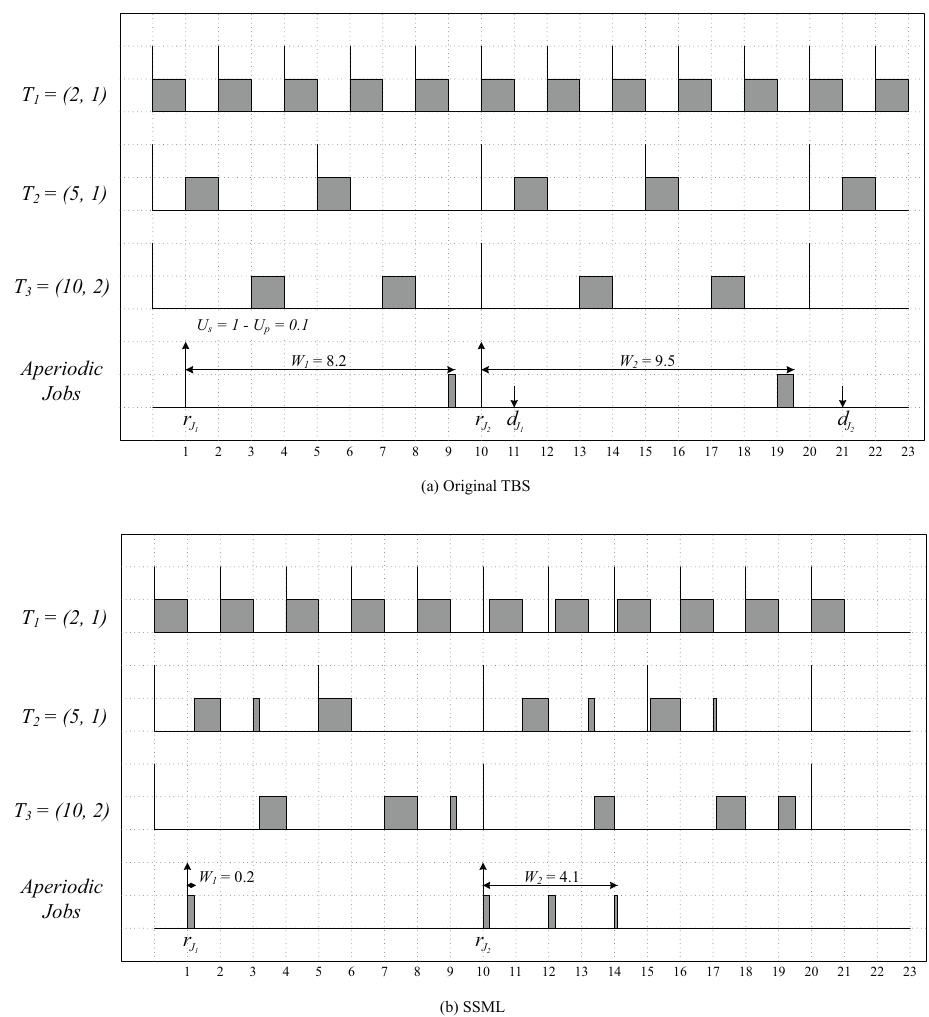
Figure 2. Example of an online slack-stealing algorithm (SSML) algorithm: panel ( a ) shows the scheduling result when applying the original total bandwidth server (TBS) algorithm, and the aperiodic task response times are 8.2 and 9.5. Panel ( b ) shows that the response times of the aperiodic tasks are reduced to 0.2 and 4.1 as a result of the SSML